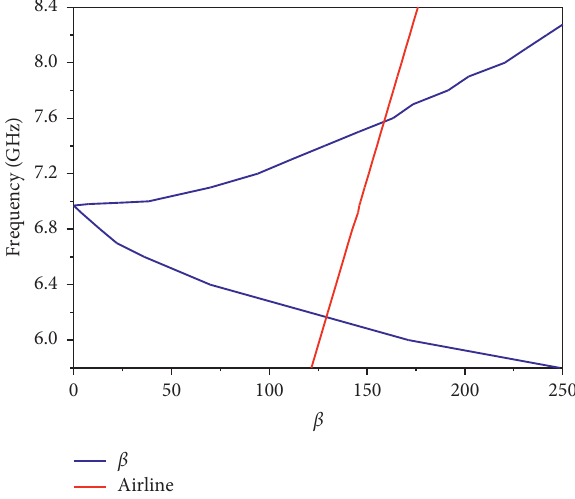
Figure 3: Dispersion curves for the proposed CRLH unit cell. Table 1: Design parameter values of the CRLH